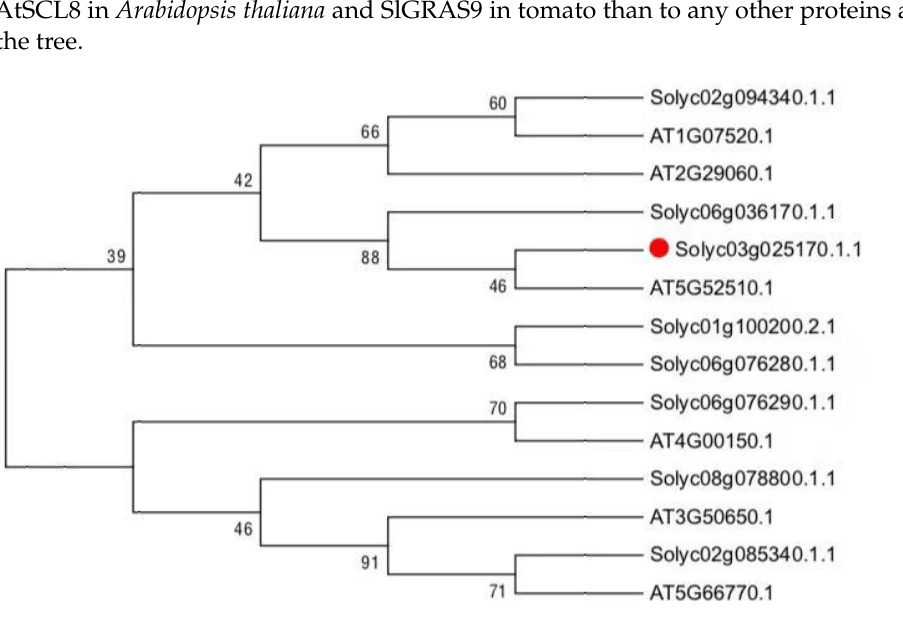
Figure 1. Phylogenetic tree of SlGRAS10 and other known GRAS proteins. A phylogenetic tree of SlGRAS10 and other GRAS proteins was constructed to show the relationship between Arabidopsis and GRAS protein from tomato.